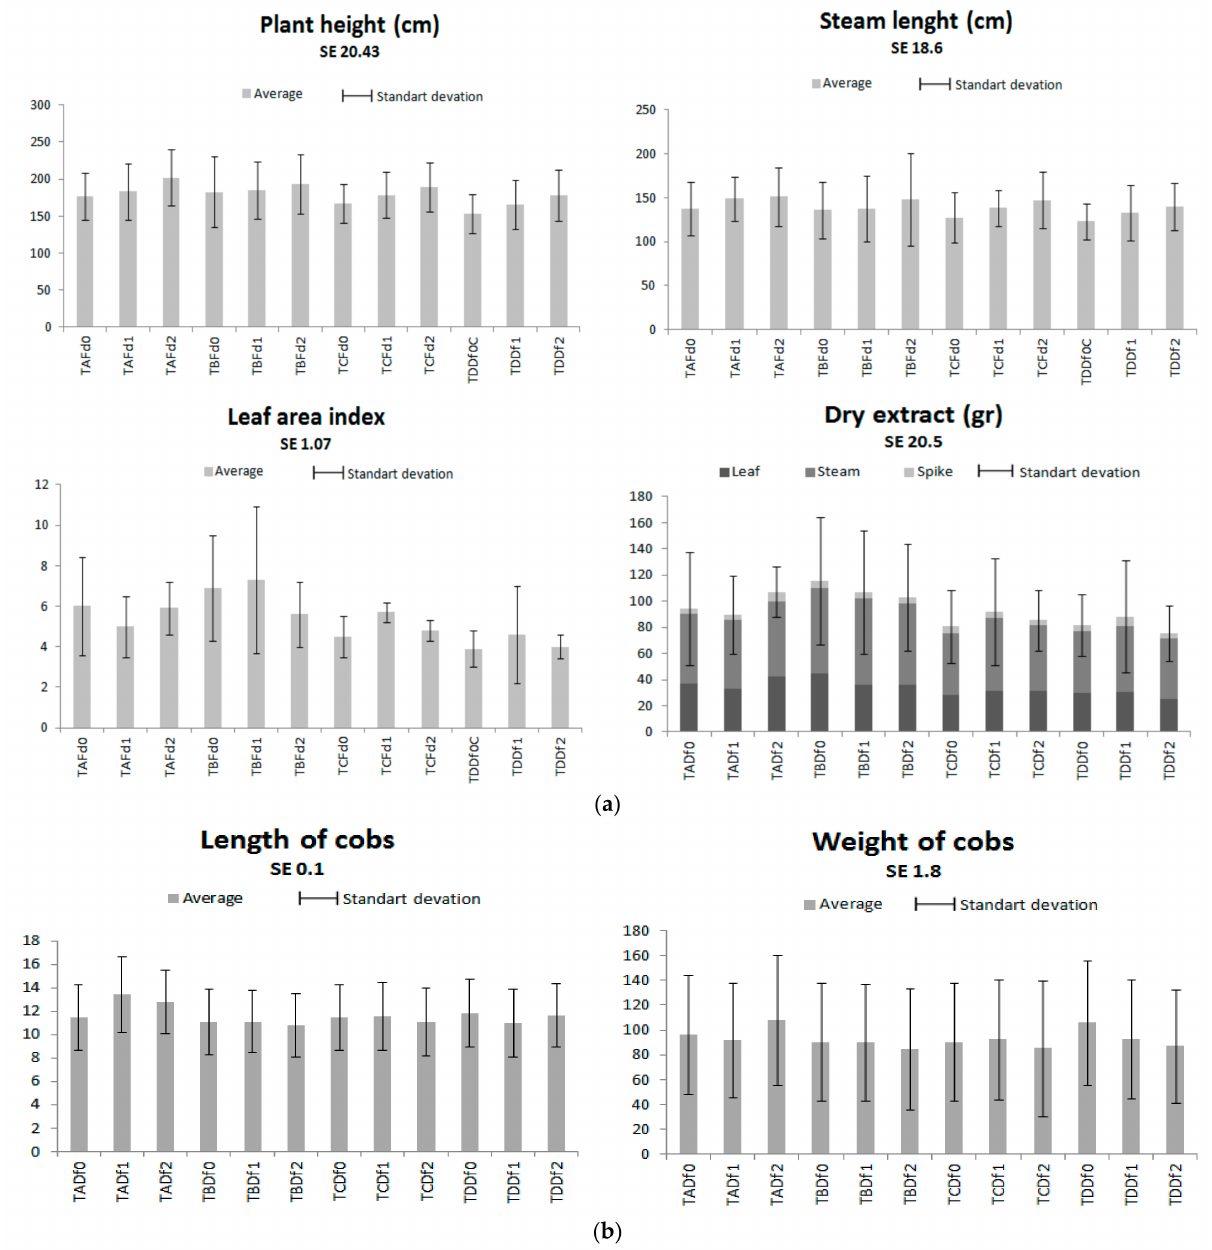
Figure 10. Statistical analysis results: plant height, steam length, leaf area index, dey extract ( a ), and length of cobs, weight of cobs ( b ). Statistical analysis (variance analysis and comparison of means) method for organic corn (2018) using the Scheffe (95%); SE: standard